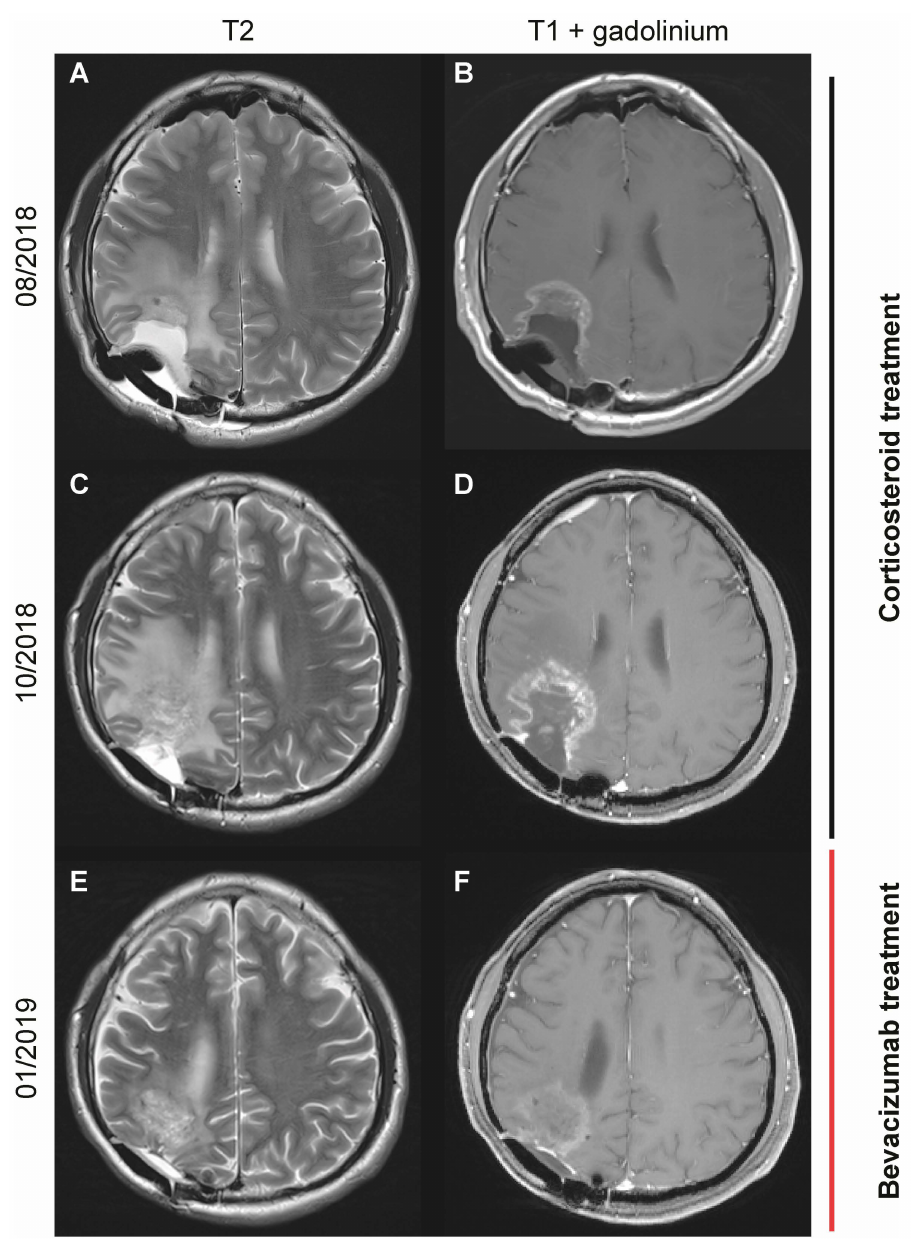
Figure 1. Brain edema and disruption of the blood–brain barrier in an index patient with cerebral radiation necrosis. MRI scans of a 46-year-old patient with glioblastoma of the right parietal lobe ( A , C , E ): T2 weighted images (WI); ( B , D , F ): T1 (WI) after intravenous gadolinium). Re-radiation was applied 10 months before the first MRI. ( A , B ) MRI shows a non-solid, necrotizing lesion with rim enhancement adjacent to the resection defect with surrounding edema. Due to worsening headache and increased rate of epileptic seizures, dexamethasone was started one month later. ( C , D ) the clinical symptoms had declined, yet the MRI shows an increasing extent of the rim-enhancing lesion and of the edema, so therapy with bevacizumab was started one month later. ( E , F ) the first follow-up MRI after two infusions of bevacizumab showed a significant reduction of contrast enhancement and edema. Treatment with dexamethasone could be stopped shortly after, but serum analysis revealed an adrenal insu ffi